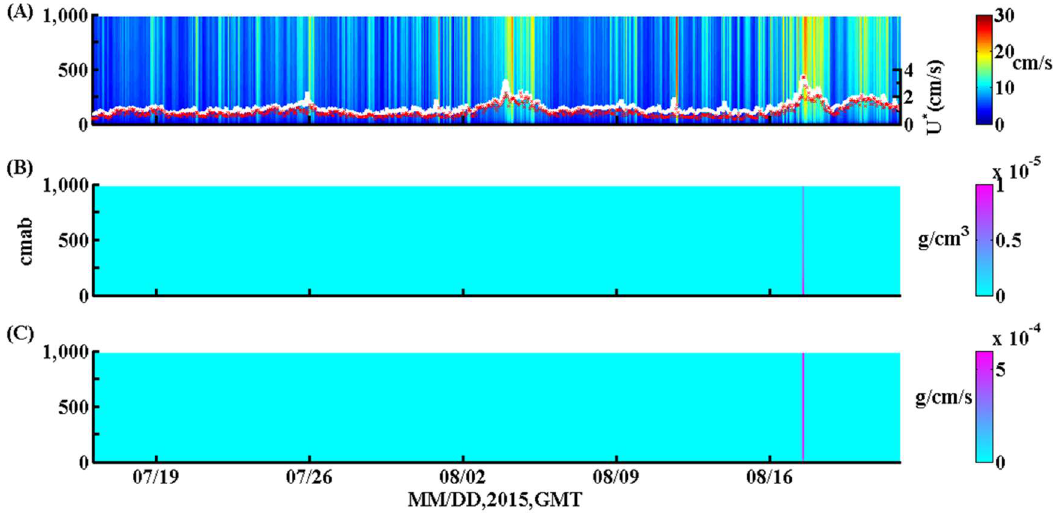
Figure 7. The model results of resuspended sediments concentration within the water column at station T1. ( A ) Current speed within the water: observed wave-current combined shear velocity (white line), and modeled wave-current shear velocity (red dot); ( B ) resuspended sediment concentration of grain size 0.005 mm within water column; ( C ) sediment transport flux within the water column (grain size 0.005 mm).